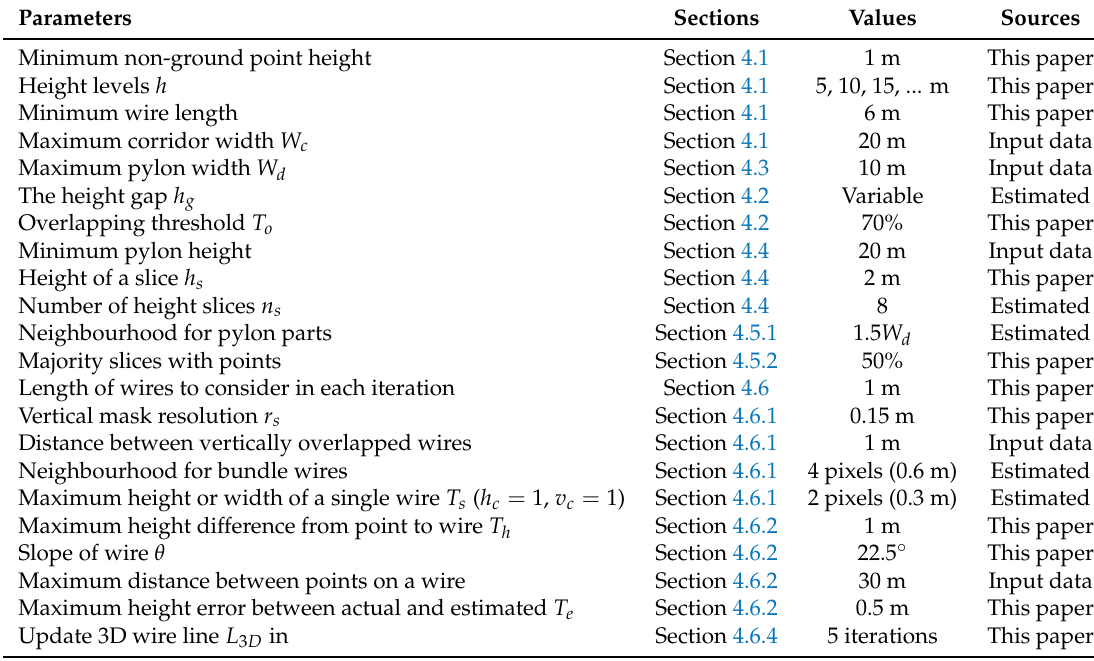
Table 1. Parameter values used in the proposed